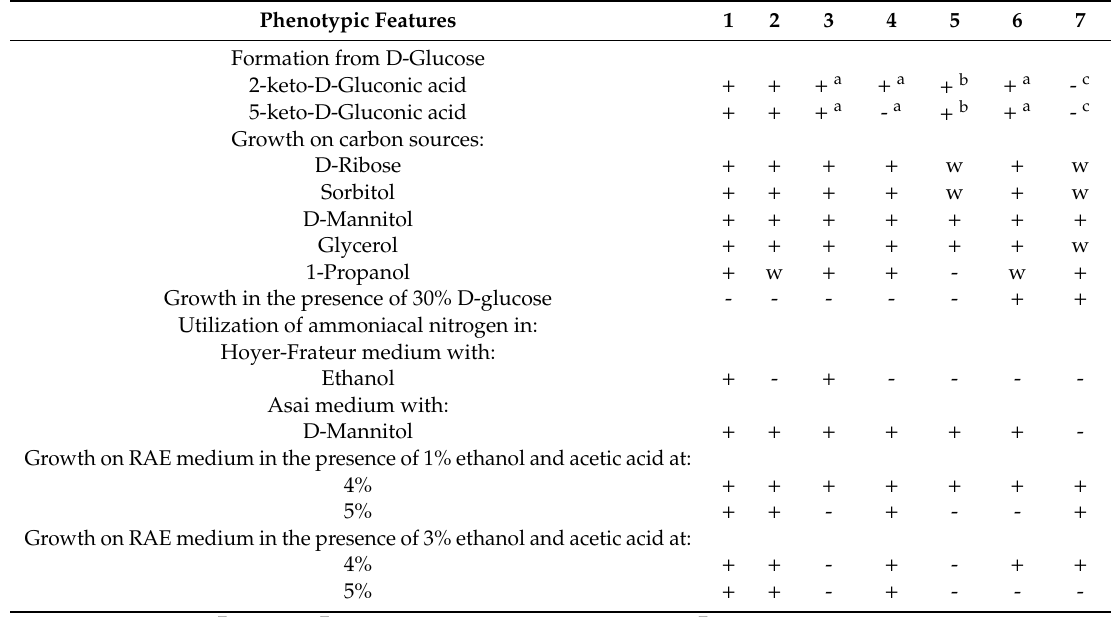
Table 2. Di ff erential phenotypic characteristics of strains AV382 and AV436 from their closest species. Phenotypic